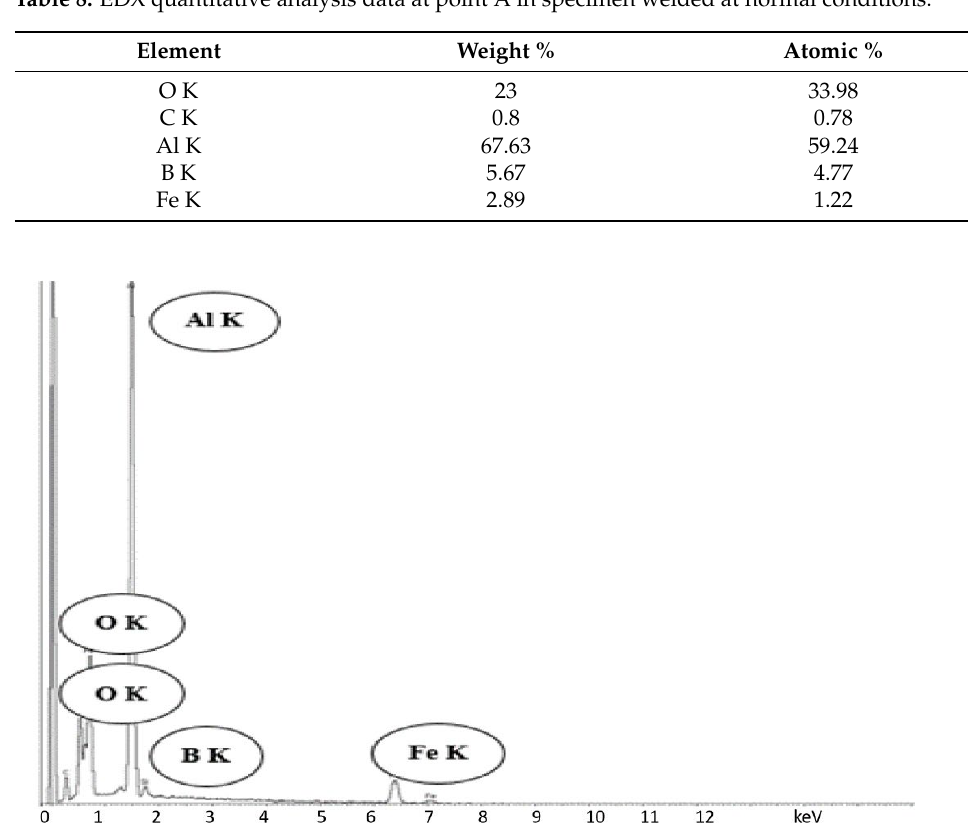
Figure 13. EDX analysis spectrum at point C in specimen welded at normal conditions.